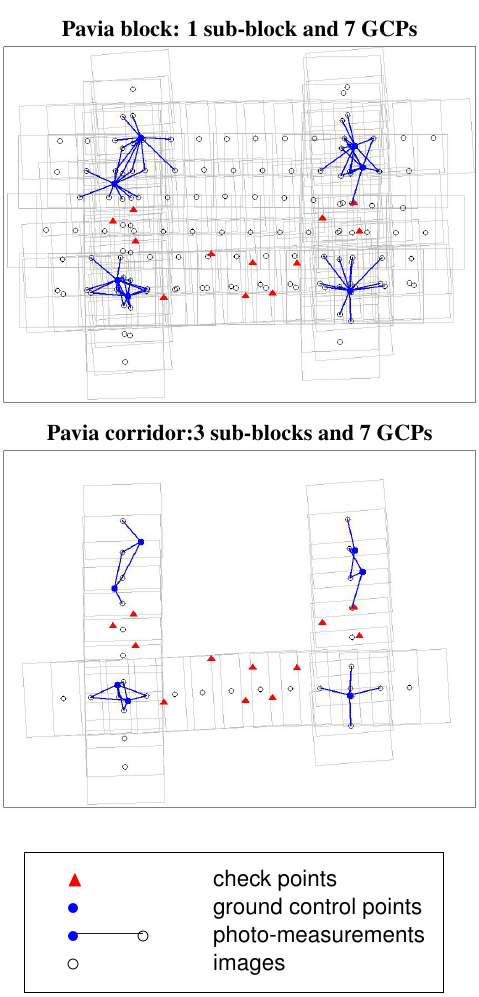
Figure 4: Pavia block and Pavia corridor